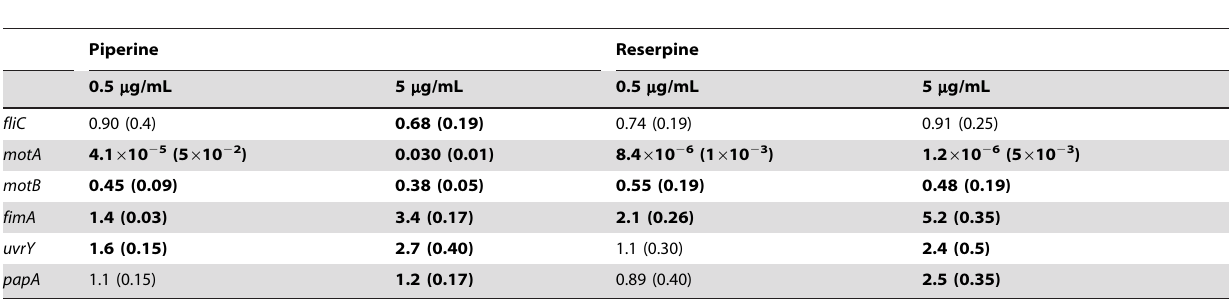
Table 1. Expression of genes responsible for motility and biofilm formation in E. coli CFT073 wild type after 48 h of growth in presence and absence of PIP and